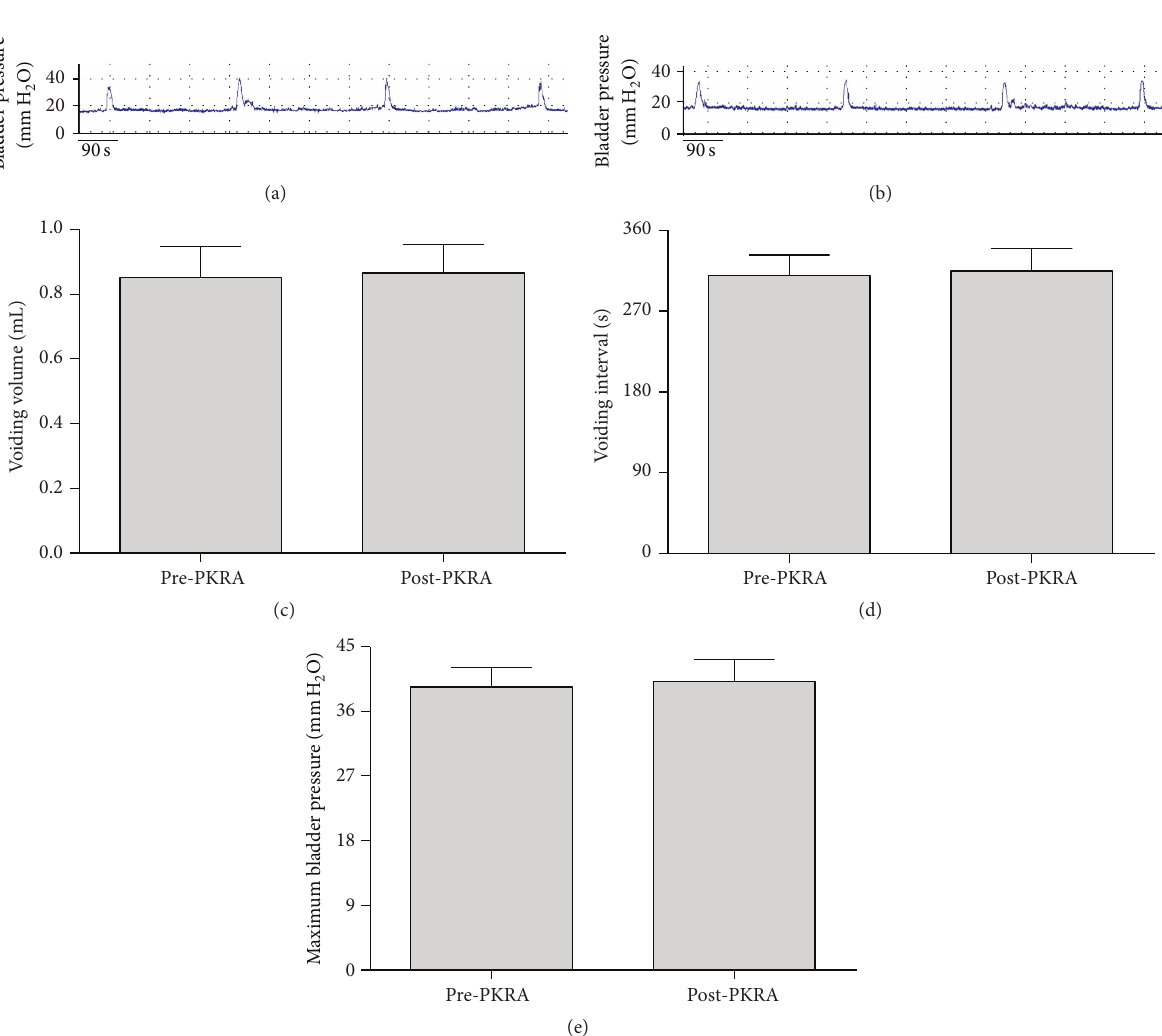
Figure5:EffectofPKRAonmodulatingbladderfunctionexaminedbycystometryinconsciousnormalrats(noCYP).(a)and(b)areoriginal recordings of pressure-volume curve in a control rat before PKRA (a) and after PKRA (b) treatment, respectively. PKRs blocking with PKRA showed no effect on urodynamic parameters examined including voiding volume (c), voiding interval (d), and maximum bladder pressure (e) in control. Sample size 𝑛 = 6 for each